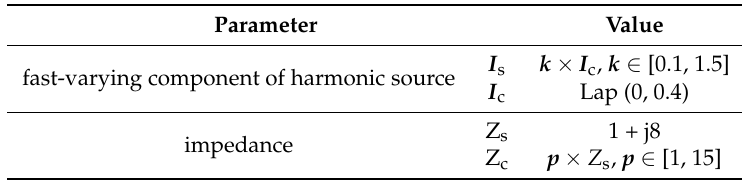
Table 1. Parameters for simulation model.